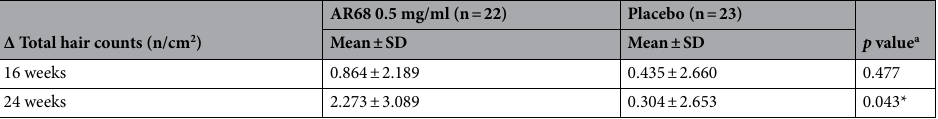
Table 3. Statistical analysis of Δ total hair counts (weeks-Baseline) between SAMiRNA-AR68 0.5 mg/ml treated and placebo groups. a Significantly different at * p < 0.05 compared with AR 0.5 mg/ml treated group and placebo group at same time point.